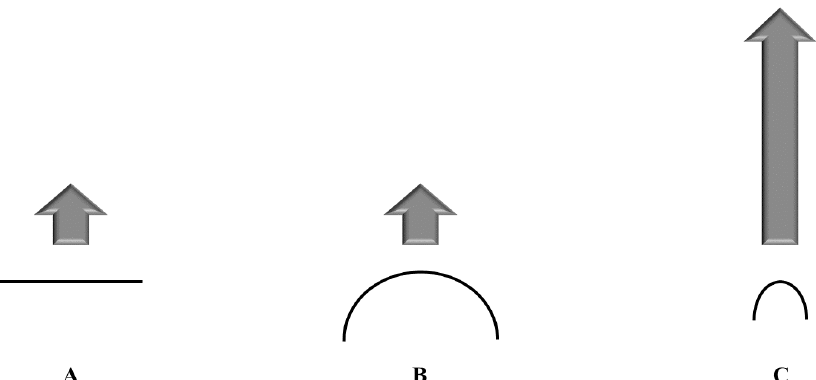
Figure 2. Increasing Dissolution Pressure Over ( A ) a Flat Surface; ( B ) Curvature of a Microparticle; ( C ) Curvature of a Nanoparticle.